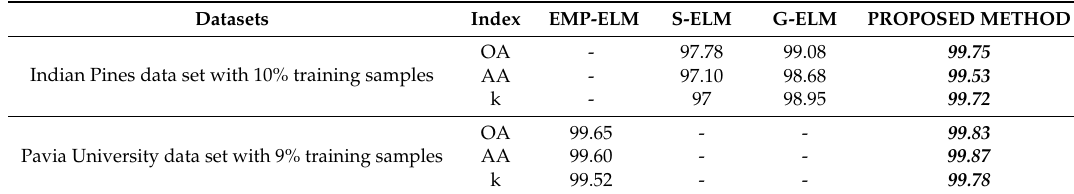
Table 4. The classification results of the proposed method and other methods. The best accuracy in each row is shown in